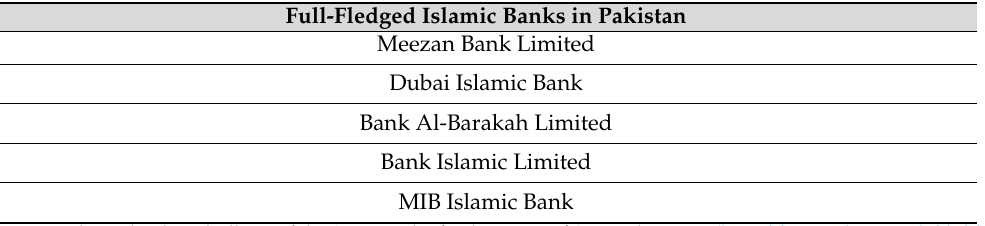
Table A3. Sampled Islamic banks.